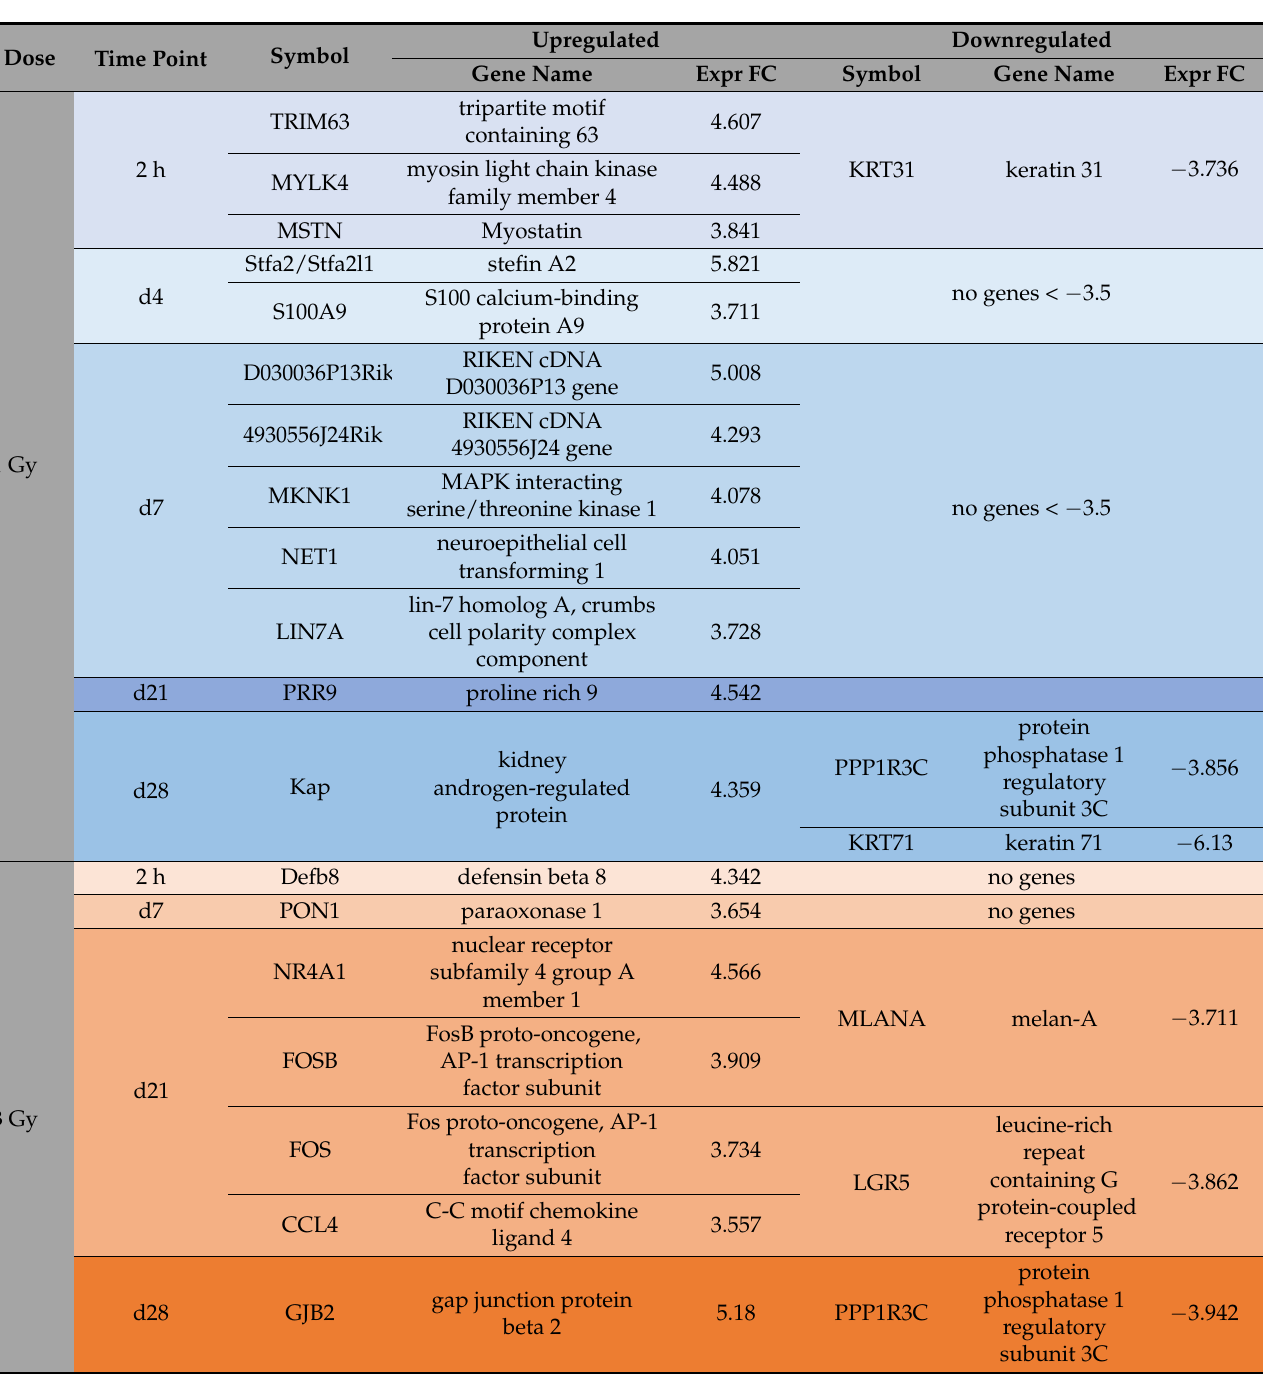
Table 3. List of time-point-unique SDTGs ( p < 0.05 and FC larger than 3.5 FC) from independent analysis of modulated genes at each IR dose. Time points that did not contain genes passing the FC threshold are not included in the